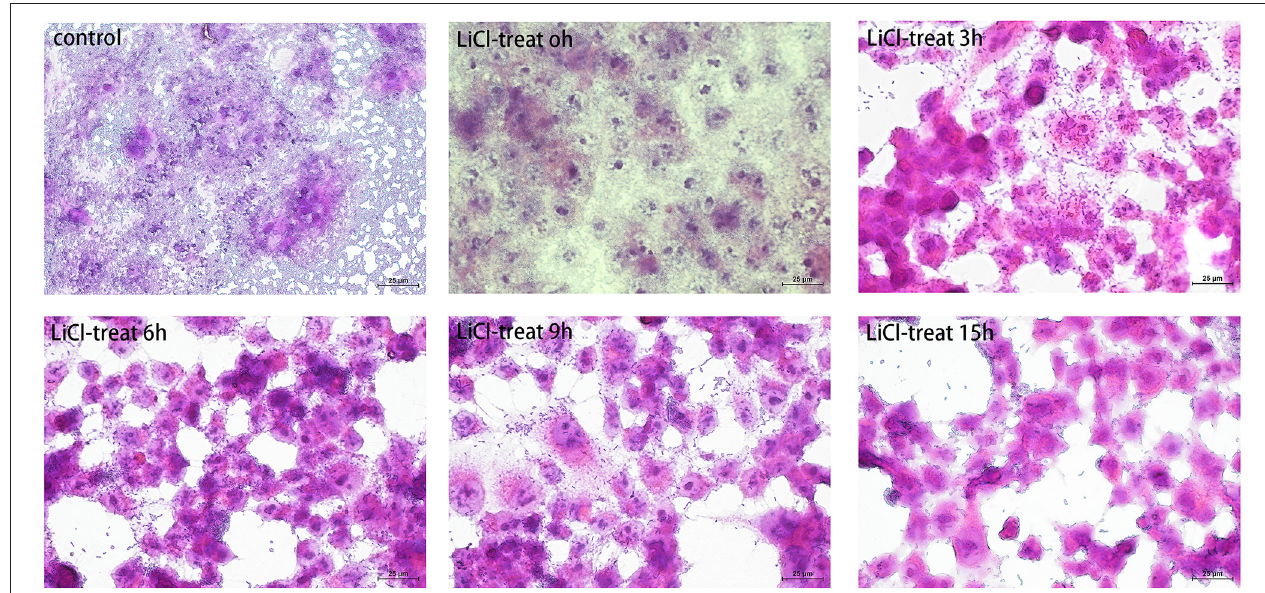
FIGURE 5 | The cells were observed under a microscope by hematoxylin and eosin (HE) staining. The L. plantarum HC-2 was treated by LiCl and then incubated with HCT116 cells for 2h. After incubation, the cells were washed with sterile PBS to remove unattached bacteria. Later, the cells were fixed with 10% formaldehyde, and finally, the cells were stained by the HE staining method and observed under a 40-fold microscope.